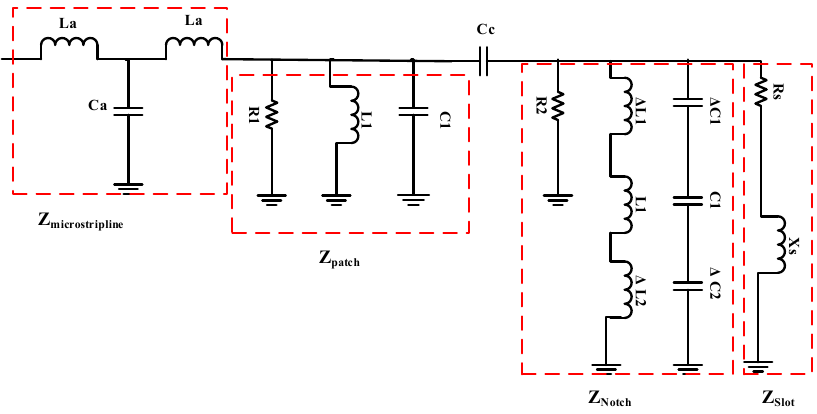
Figure 12. Electrical circuit model of the proposed textile antenna.